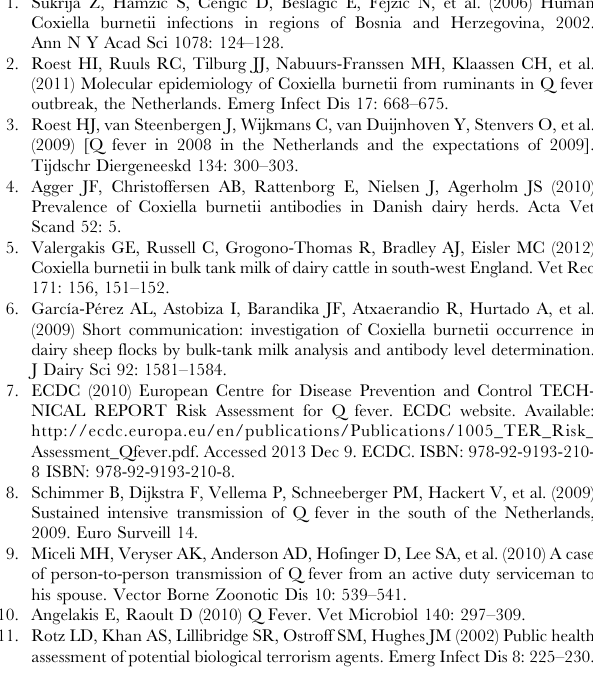
Table S1 In silico microsatellite (MS) analysis. Sequence lengths of 17 variable MS loci and the calculated number of repeats in 21 genomes. Homoplasy was observed in seven out